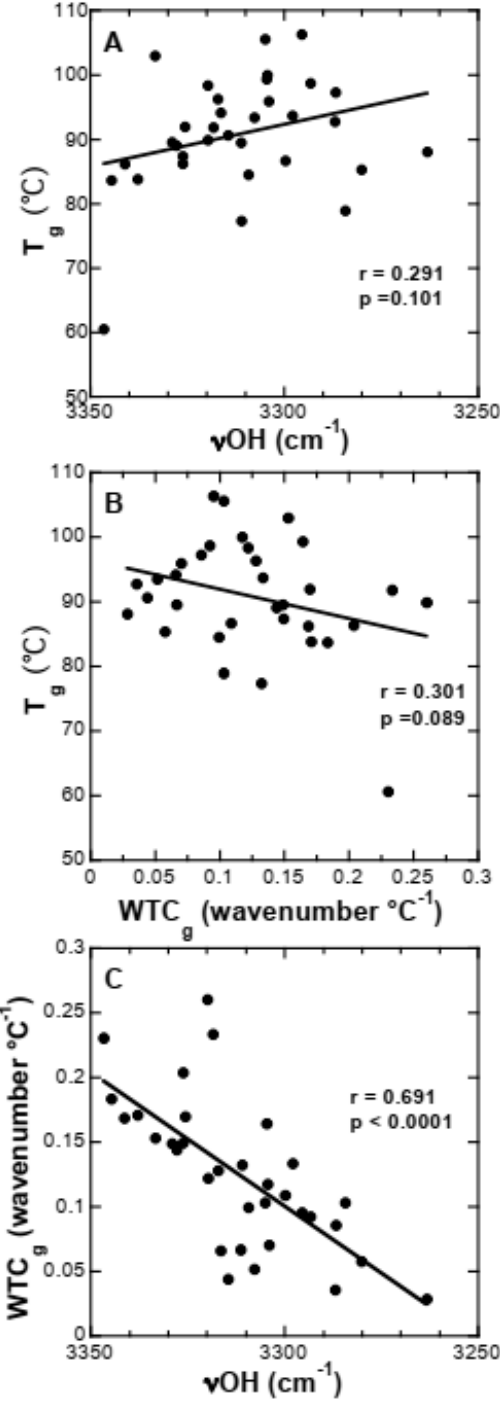
Figure 8. Correlation analysis between Tg, WTCg and ν OH. Data from all samples analyzed in this Figure 8 . Correlation analysis between T g , WTC g and ν OH. Data from all samples analyzed in this study (Suc dissolved in pure H2O, Tris and NaP containing no proteins, LEA proteins or globular study (Suc dissolved in pure H 2 O, Tris and NaP containing no proteins, LEA proteins or globular reference proteins) were used to correlate Tg with ν OH ( A ), Tg with WTCg ( B ), and WTCg with reference proteins) were used to correlate T g with ν OH ( A ) , T g with WTC g ( B ) , and WTC g with ν OH ( C ). The calculated r- and p-values are indicated in each ν OH ( C ) . The calculated r- and p-values are indicated in each panel.